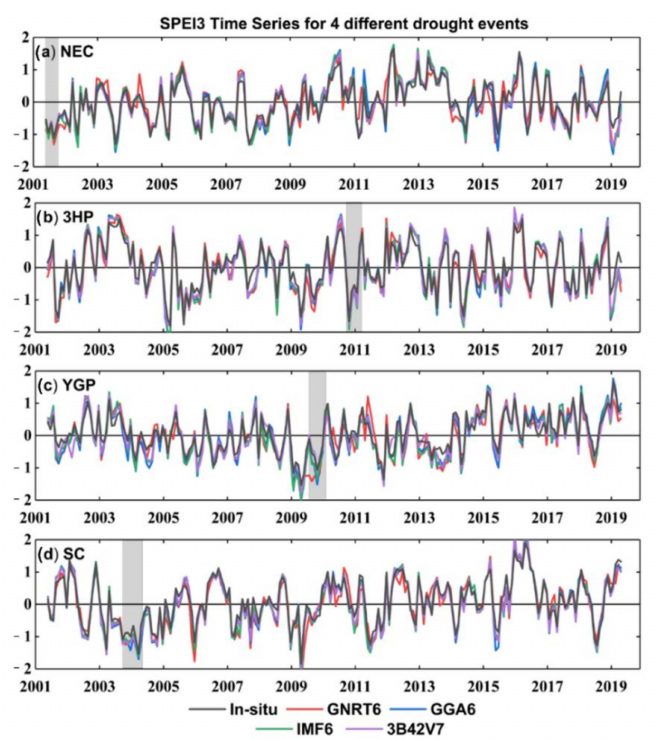
Figure 9. Time series of regional-averaged SPEI3 of the four typical drought-affected areas(( a ) NEC, ( b ) 3HP, ( c ) YGP and ( d ) SC) during 2001–2019. Gray backgrounds indicate the period of the typical drought events.